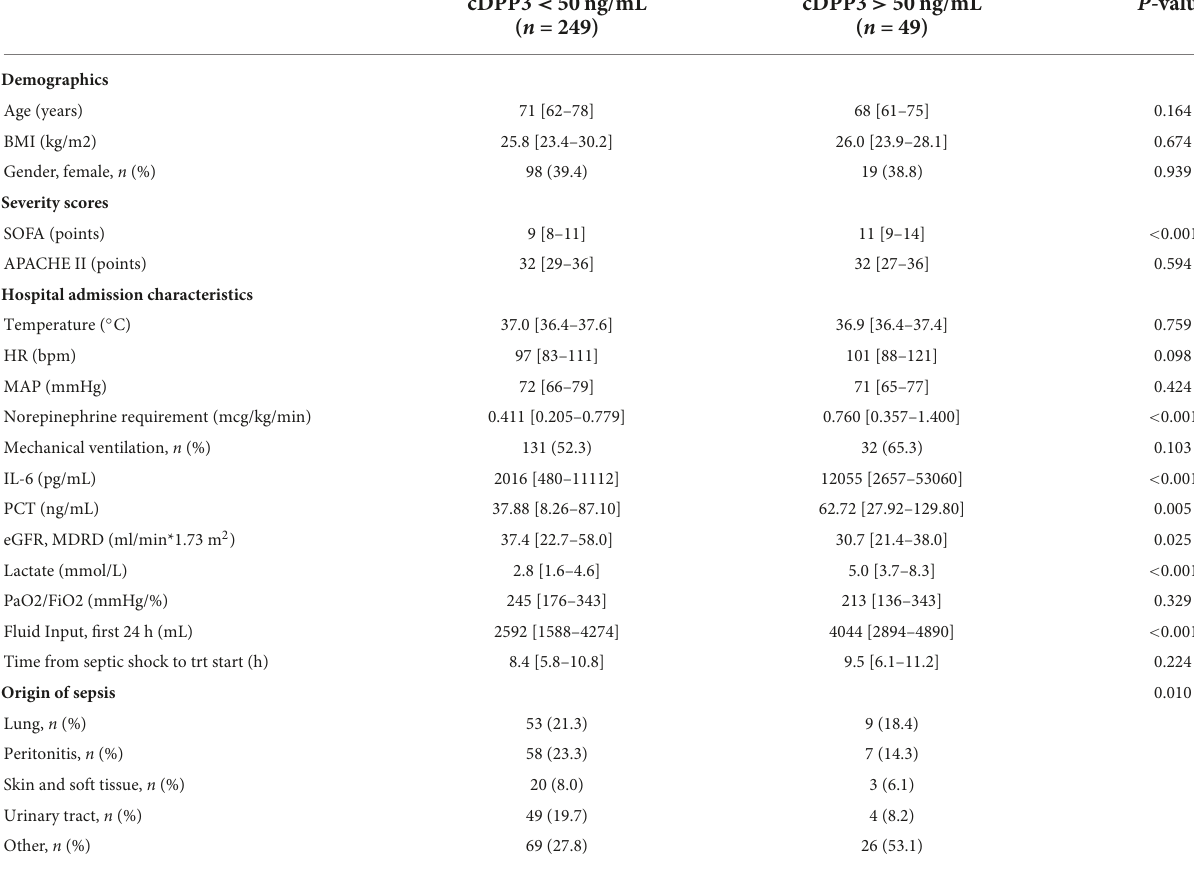
TABLE 1 Demographics and baseline characteristics.